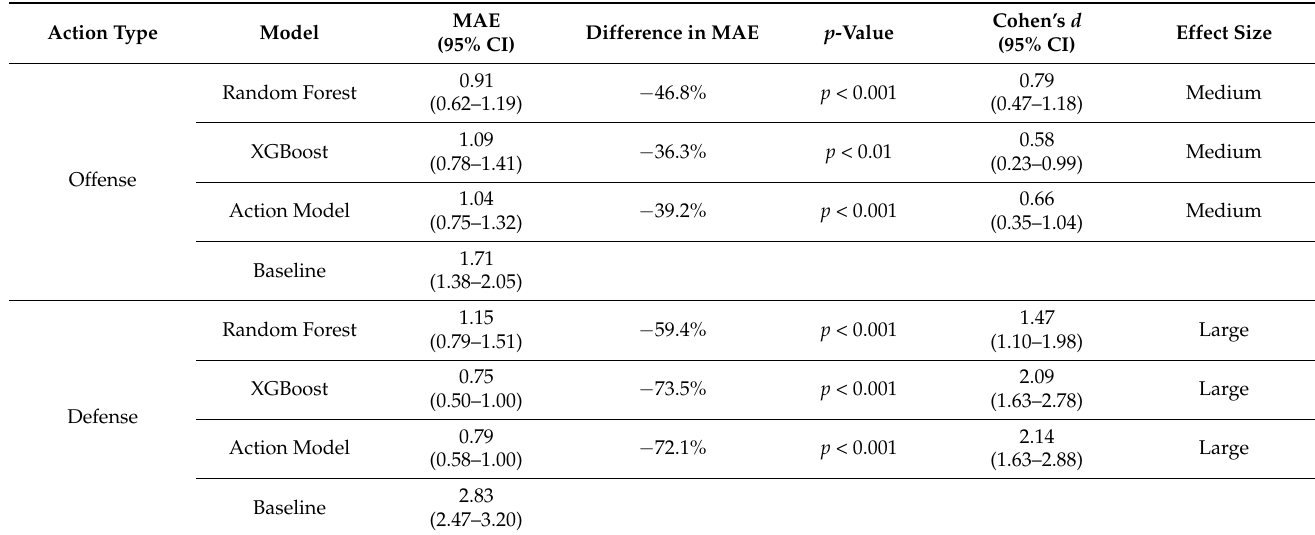
Table 2. Accuracy of the machine learning models for all offensive and defensive performance scores. Offensive performance is most accurately predicted by the random forest model, and XGBoost model is the best model for defensive actions. Models that only use action type as predictors are only slightly less accurate than our best machine learning models, suggesting that adding predictors related to external and internal training load does not result in large improvements in the prediction of offensive and defensive performance.